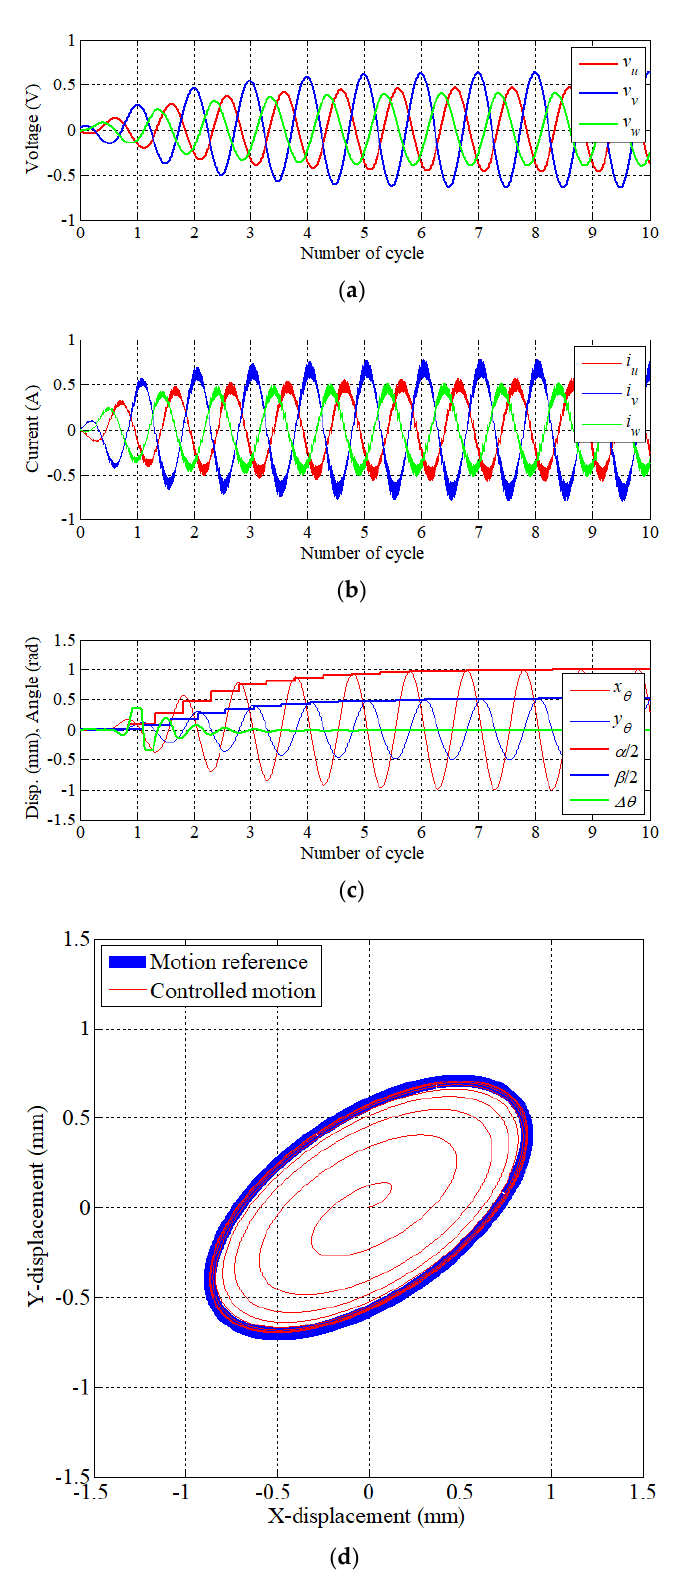
Figure 15. Result of elliptical motion ( α : 2 mm, β : 1 mm, θ : 35 deg.) ( a ) Phase voltage reference, ( b ) phase current, ( c ) displacement, and ( d ) trajectory of